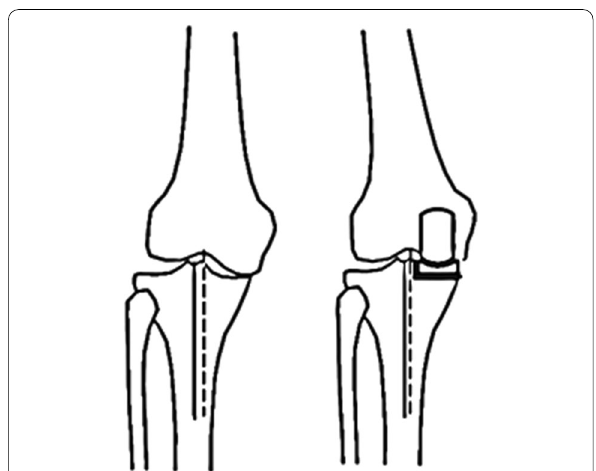
Fig. 1 The proximal tibial axis (solid line) is drawn through the midpoint of the tibial crest and the midpoint of the tibial shaft about 120 mm from the tibial articular surface, with a parallel dotted line representing the proximal tibial axis (dotted line) being drawn through the apex of the femoral intercondylar fossa. The distance between these two lines is the CTFS